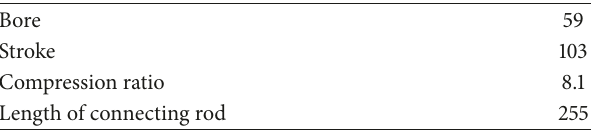
Table 1: Engine dimensions (in mm).